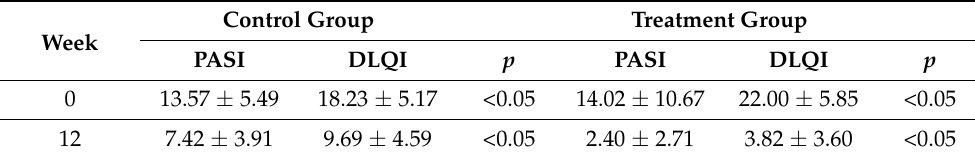
Table 14. Results of treatment with statins, measured by PASI, reported by Lin et al.